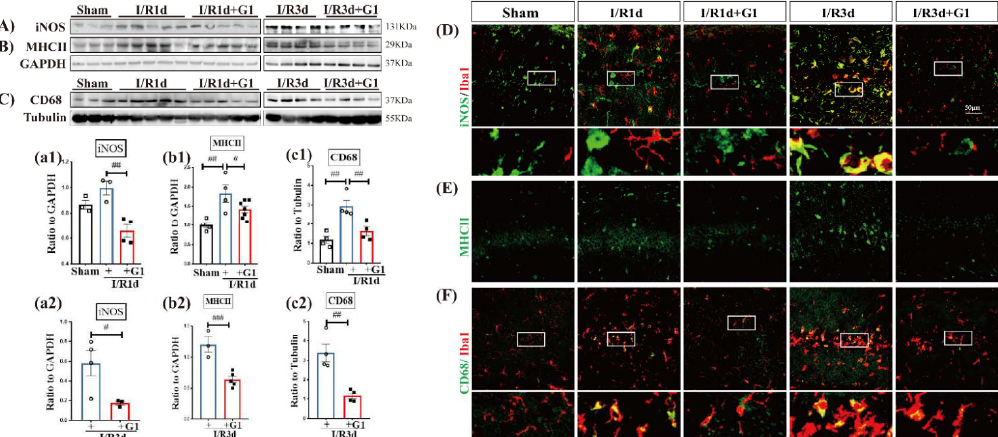
Figure 1. GPER activation induced by G1 suppressed M1 phenotypic markers of microglia in the ovariectomized rat hippocampal CA1 region following GCI. Hippocampal CA1 protein samples from animals in the sham group and animals 1 day and 3 days after GCI treated with or without G1 were subjected to Western blot analysis of microglial M1 markers iNOS ( A , a1 , a2 ), MHCII ( B , b1 , b2 ), and CD68 ( C , c1 , c2 ). ( D – F ) Brain coronal sections were used to perform immunofluorescence staining. Representative photomicrographs of ( D ) iNOS (green) and Iba1 (red), ( E ) MHCII (green), and ( F ) CD68 (green) and Iba1 (red) staining are shown. Data are shown as the means ± SEs from three to seven independent samples per group ( N = 3–6). # p < 0.05, ## p < 0.01 and ### p < 0.001, Scale bar, 50 µ m. Magnification, 40 × . iNOS, inducible nitric oxide synthase; Iba1, Ionized calcium binding adaptor molecule 1; I/R, ischemia reperfusion. White Box in subfigure D, F, GPER, G-protein-coupled estrogen receptor 1. Biology 2023 , 12 , x FOR PEER REVIEW